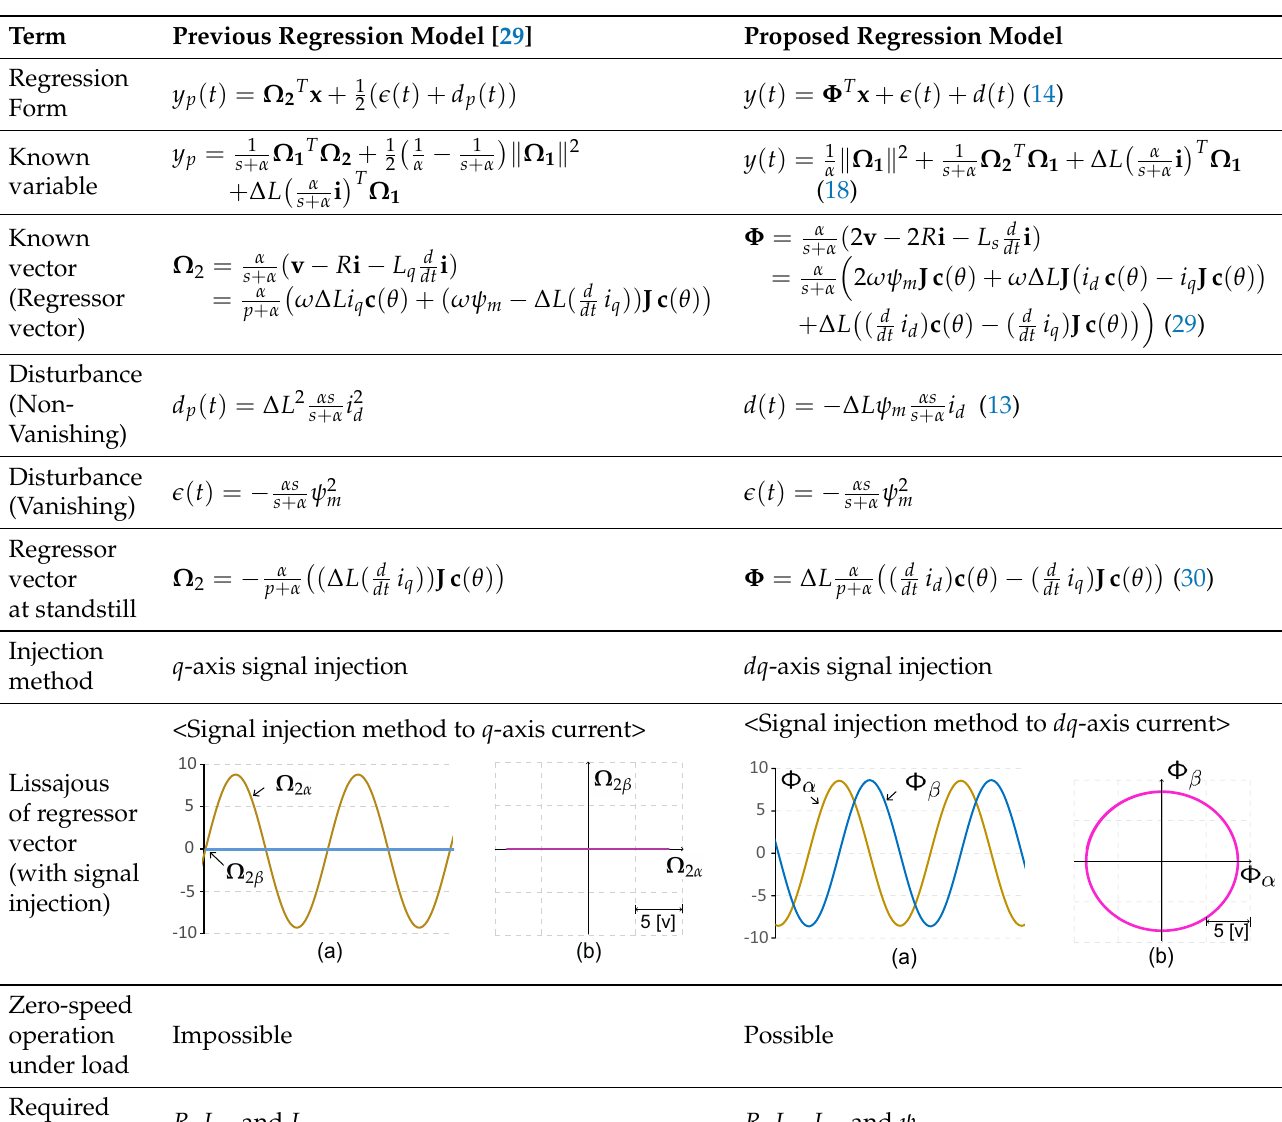
Table 1. Comparison of the proposed regression model with the previous